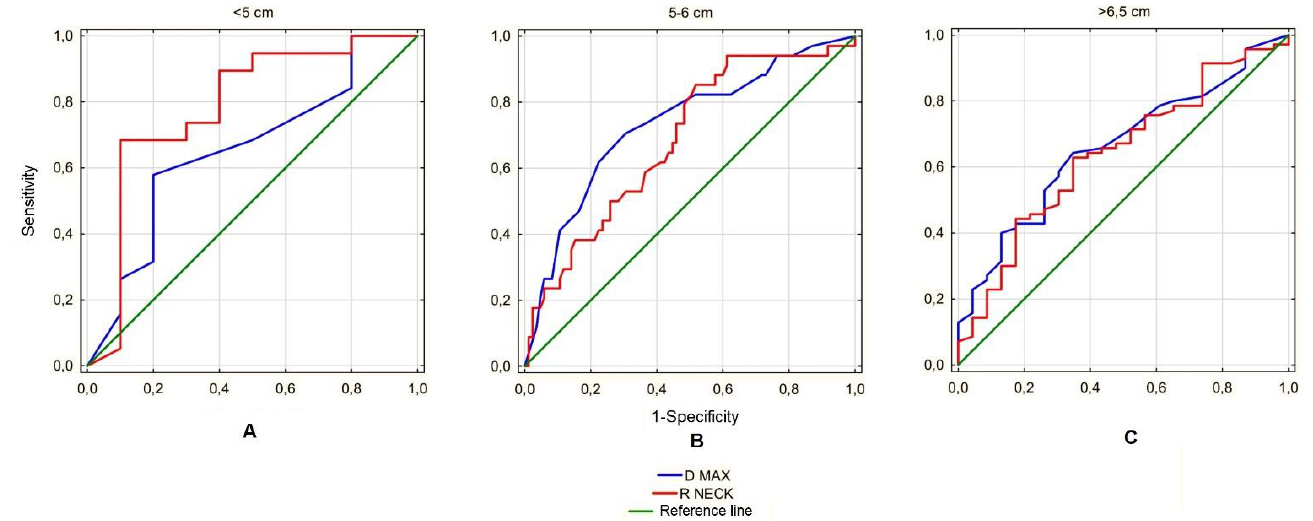
Figure 7. ( A ) ROC curves for the predictive value of R NECK compared with D MAX and the reference line in the group of aneurysms with D MAX < 5 cm. AUC for D MAX: 0.65, AUC for R NECK: 0.783. ( B ) ROC curves for the predictive value of R NECK compared with D MAX and the reference line in the group of aneurysms with D MAX 5–6.5 cm. AUC for D MAX: 0.729, AUC for R NECK: 0.68. ( C ) ROC curves for the predictive value of R NECK compared with D MAX and the reference line in the group of aneurysms with D MAX > 5 cm. AUC for D MAX: 0.658, AUC for R NECK: 0.641.